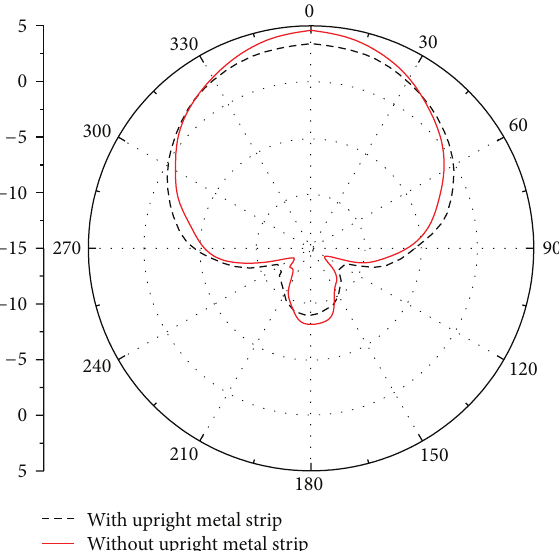
Figure 4: Simulated radiation pattern of the L1 band antenna.